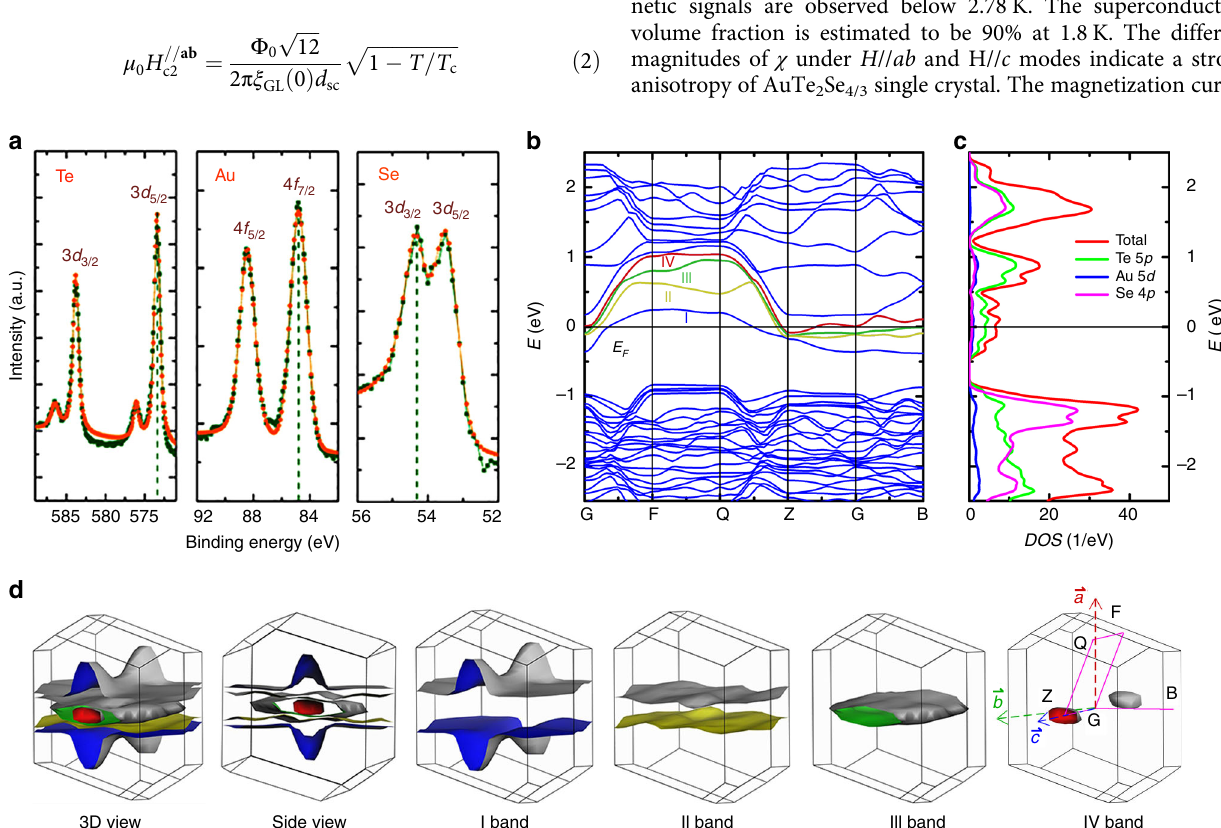
Fig. 3 Electronic structure of AuTe 2 Se 4/3 . a The XPS pattern of AuTe 2 Se 4/3 at 300 K. The olive and orange dots and lines are the measured data and fi tted curves. b The scalar relativistic band structure of AuTe 2 Se 4/3 . The four bands crossing the Fermi level are colored as blue, yellow, green, and red. c The projected density of states of AuTe 2 Se 4/3 . d The Fermi sheets of AuTe 2 Se 4/3 at 3D view, side view and four separated bands in the fi rst Brillouin zone. The G point is the zone center. The coordination a , b , and c are the real space